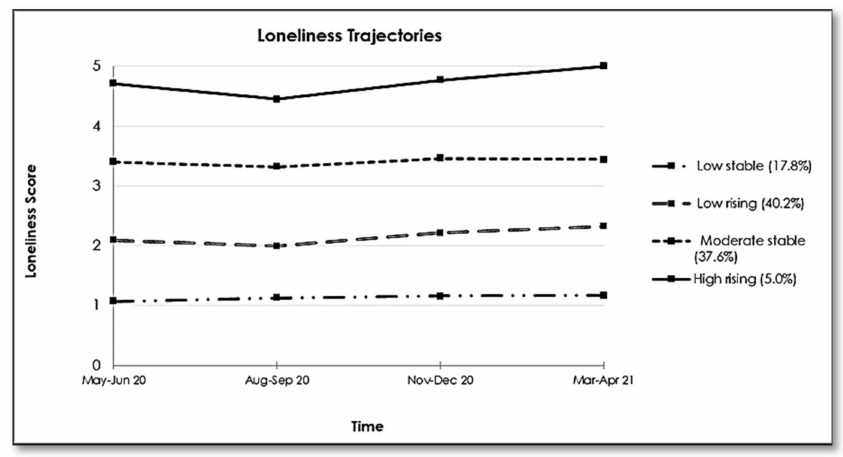
Figure 2. Trajectories of Loneliness among French participants of the COMET study (N =